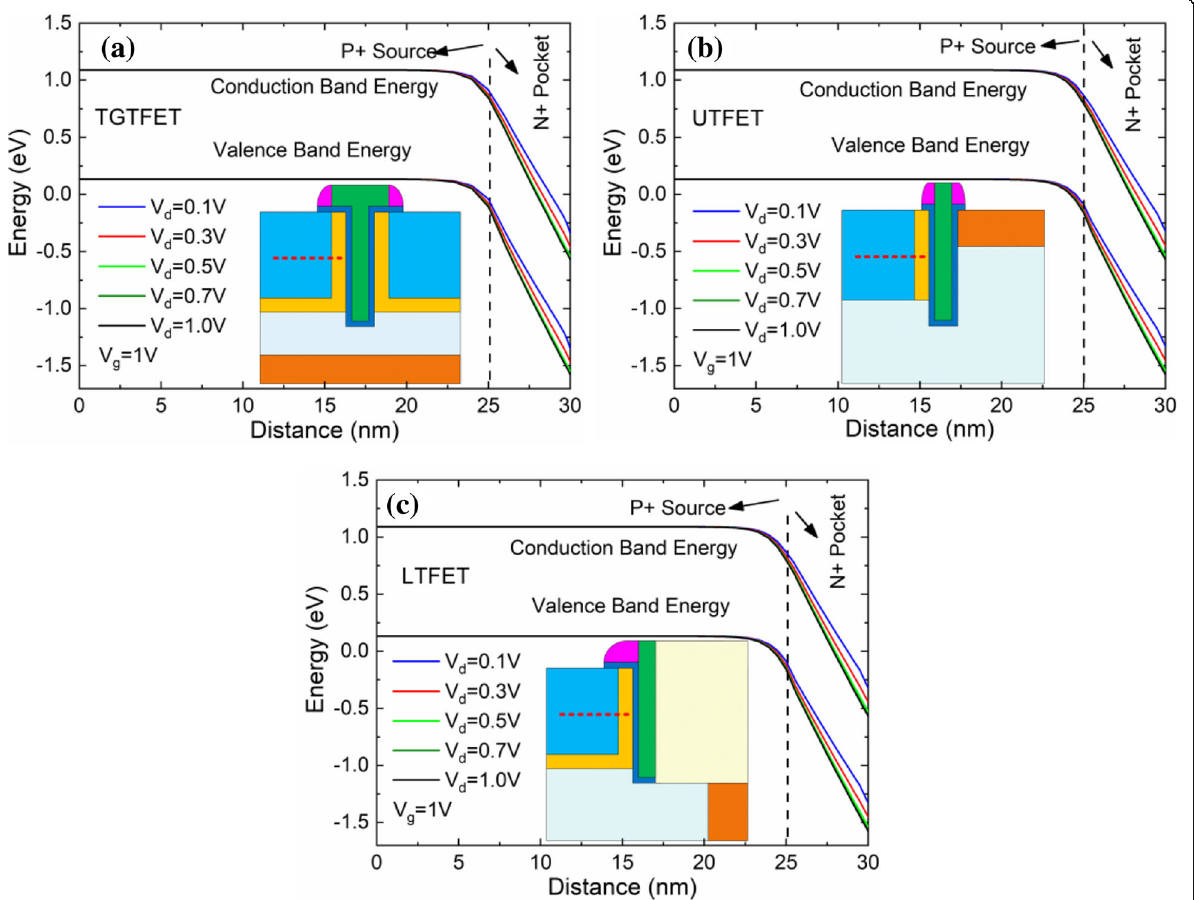
Fig. 13 The energy band structure of a TGTFET, b UTFET, and c LTFET at V g =